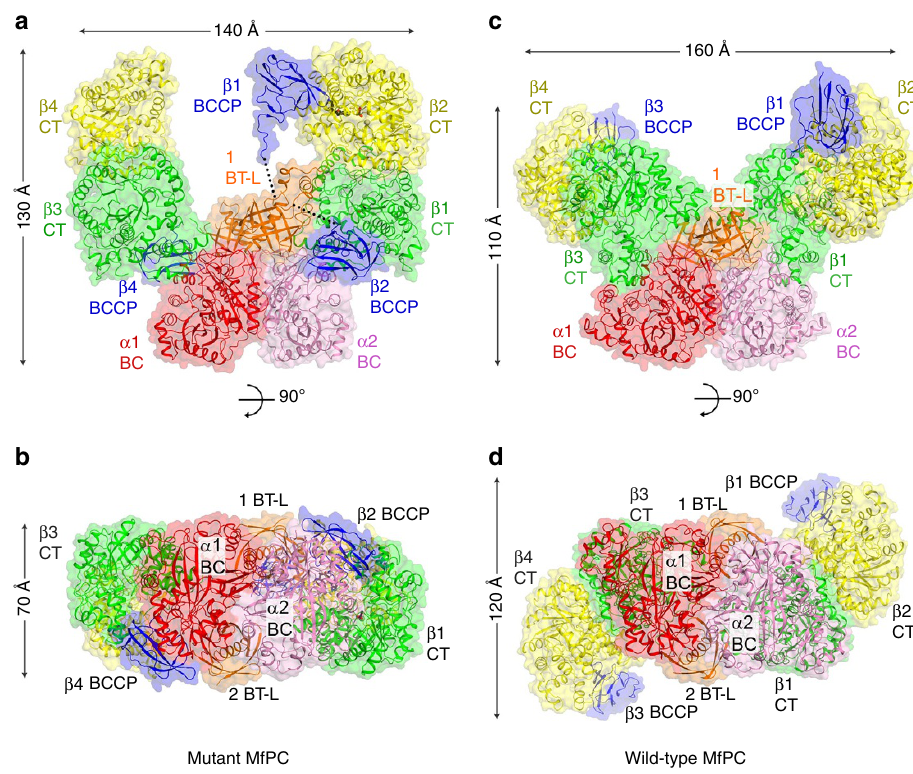
Figure 2 | Structures of MfPC holoenzyme. ( a ) Schematic drawing of the mutant MfPC a 2 b 4 holoenzyme structure, having the shape of the letter U in this view. The domains are coloured according to Fig. 1a, except the BC domain of the second a subunit is coloured in pink. BT-L, BT-like domain. ( b ) Structure of the mutant MfPC holoenzyme viewed down the BC domain dimer, along the arrow of a . ( c ) Structure of wild-type MfPC holoenzyme, having the shape of a butterfly in this view. ( d ) Structure of the wild-type MfPC holoenzyme viewed down the BC domain dimer, along the arrow of c . The two distal b subunits ( b 2 and b 4) are splayed away from each other, and other differences to the mutant MfPC holoenzyme are also clearly visible by comparing with b